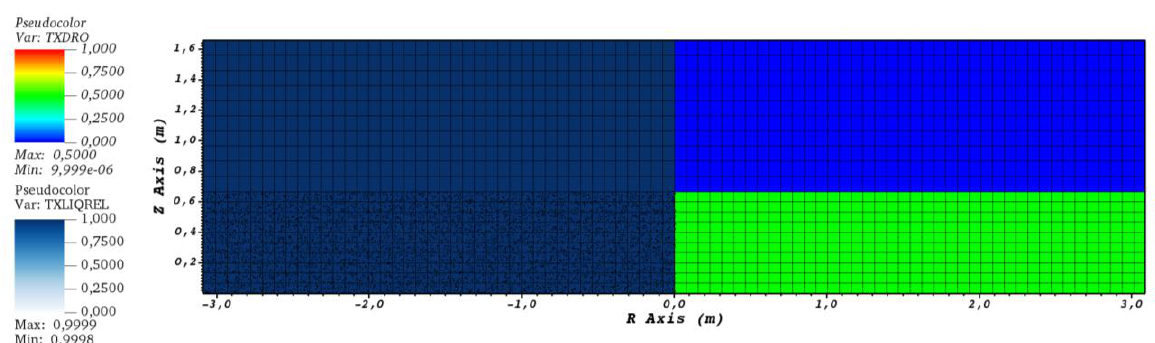
Figure 3: MC3D pre-calculation model at time t = 0 s: debris ratio on the right and local liquid water ratio on the left